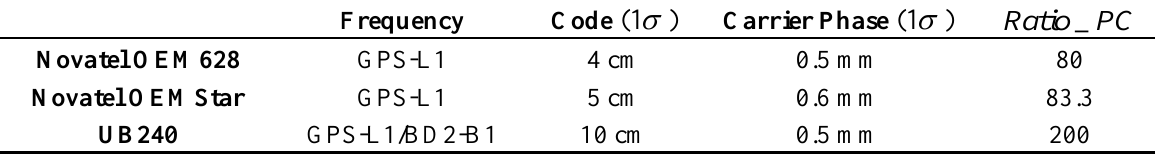
Table 1. The nominal measurement precisions of three GNSS OEM